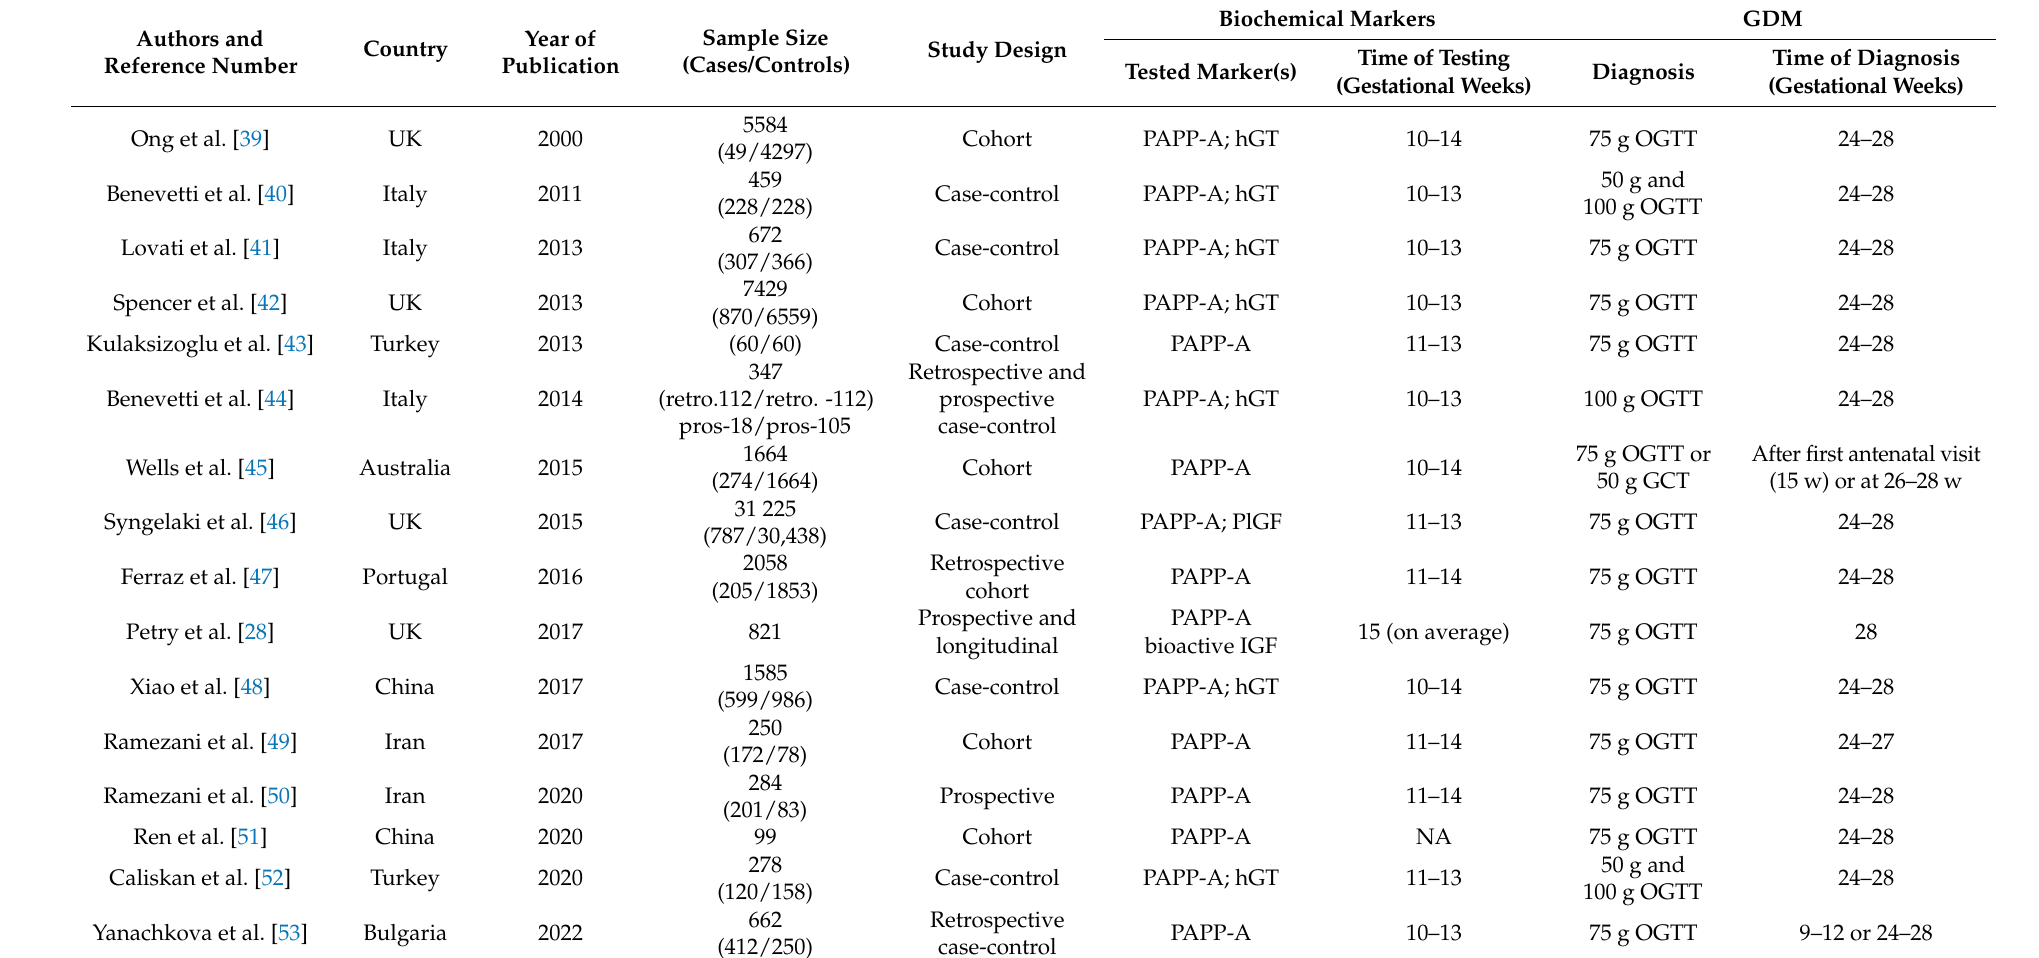
Table 1. Studies showing an inverse relationship between serum PAPP-A levels and GDM